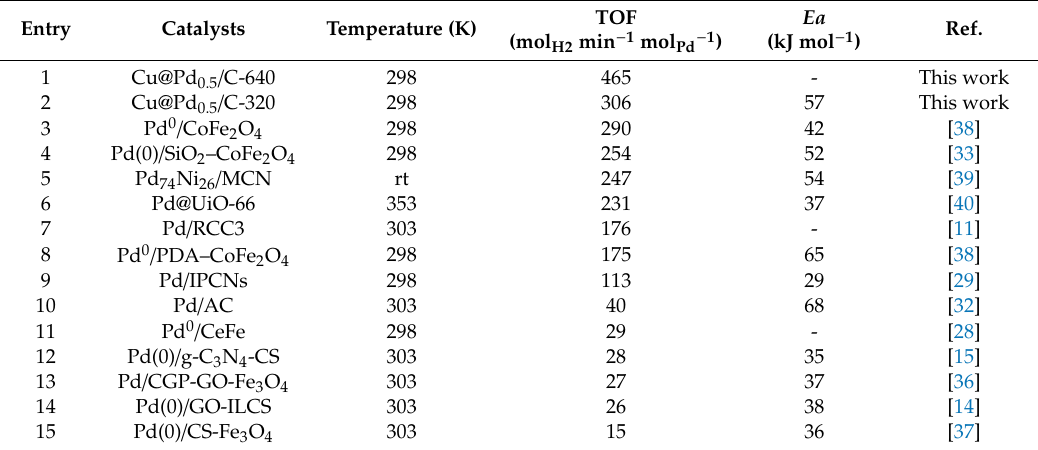
Table1. Catalyticactivityforthereportedpalladiumcatalystsinthehydrolysisofammoniaborane (AB).